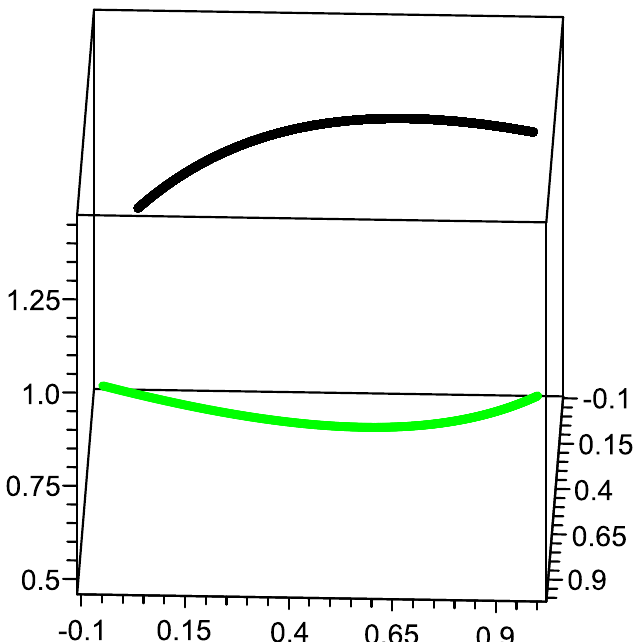
Figure 1. the lightlike rectifying curve (black curve) and the projection (green curve) in S 2